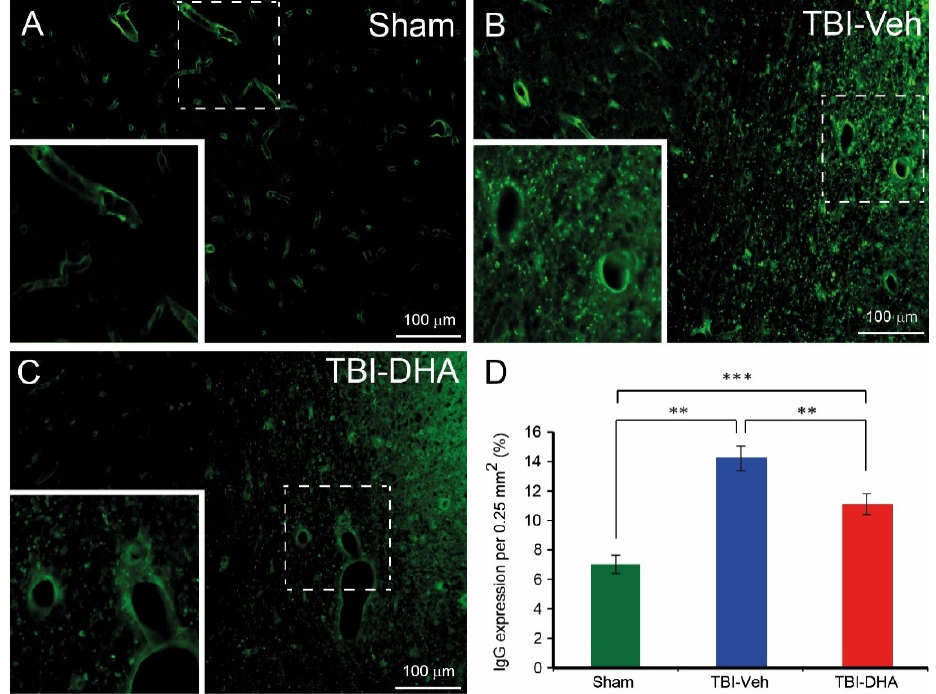
Figure 3. DHA-treated TBI rats exhibited less immunoglobulin G (IgG) extravasation at the peri-injury site than the vehicle-treated TBI rats at 7 days post injury. ( A ) In sham-operated rats, no visible IgG expression was observed outside the blood vessels. ( B ) Vehicle-treated TBI rats exhibited lots of IgG extravasation within the cerebral parenchyma. ( C ) DHA-treated TBI rats exhibited some IgG extravasation within the cerebral parenchyma. ( D ) Analysis of IgG extravasation at the pericontusional site revealed a significantly reduced IgG extravasation in DHA-treated rats (red, n = 6) compared vehicle-treated TBI rats (blue, n = 6) at 7 days post injury. IgG extravasation in sham-operated rats (green, n = 4) was significantly lower than TBI rats. The ** and *** indicate p < 0.01 and p < 0.001, respectively.